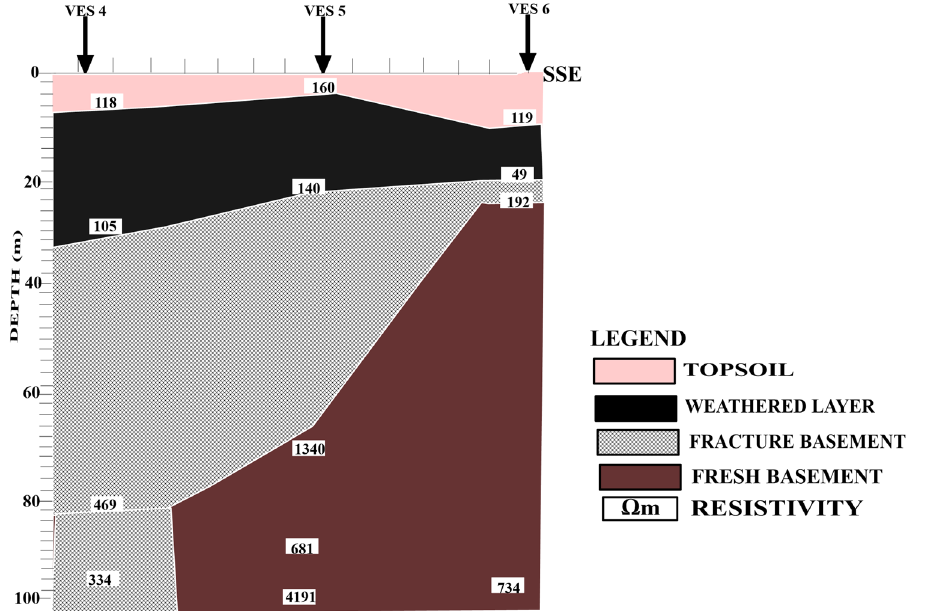
Figure 6. 2D Geoelectric Section along NNW–SSE Cross